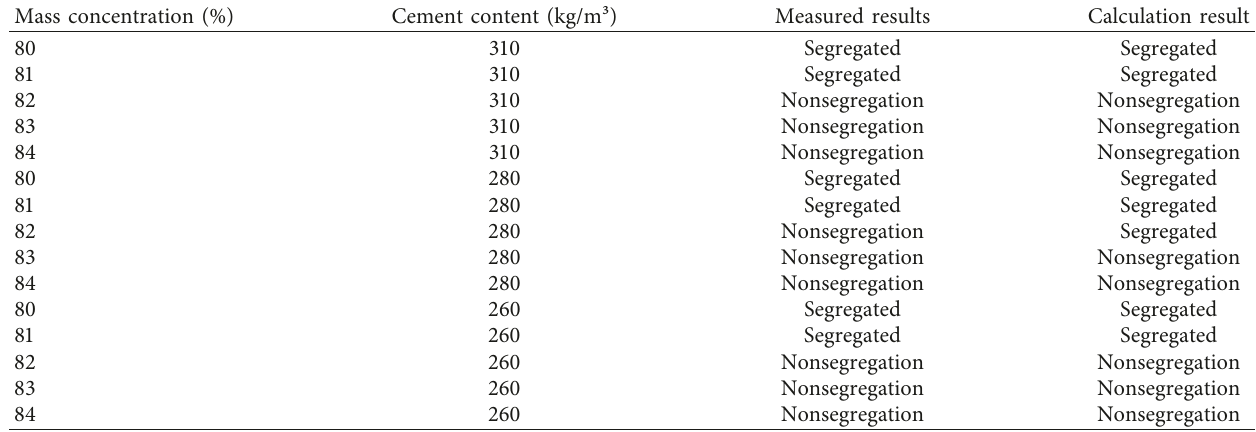
Table 6: Homogeneity judgment of slurry.